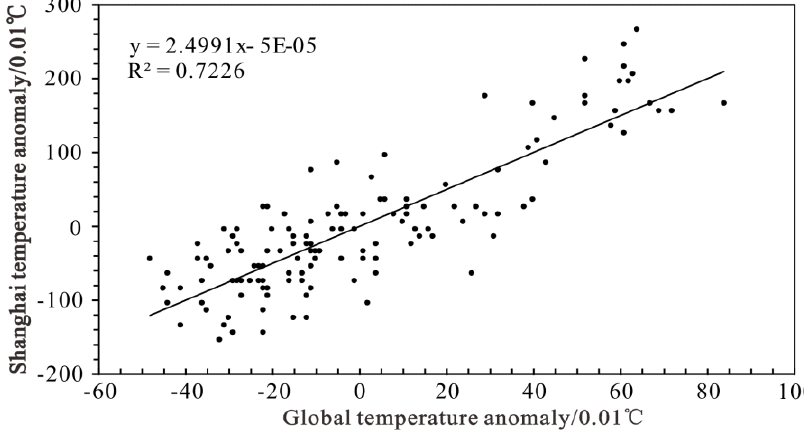
Figure 6 . Regression equation of temperature anomaly for Shanghai and globally. Figure 6. Regression equation of temperature anomaly for Shanghai and